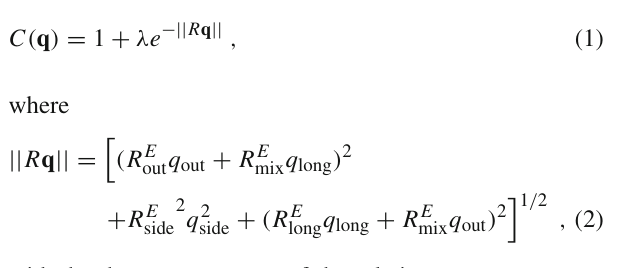
Fig. 1 Points represent the interferometry correlations for pions in central (0–1%) p+Pb collisions, calculated in the viscous hydrody- namic model; C ( q out , q side = 0 , q long = 0 ) (panel (a)), C ( q out = 0 , q side , q long = 0 ) (panel (b)), and C ( q out = 0 , q side = 0 , q long ) (panel (c)).Thesolidlinesrepresentthefittedcorrelationfunctionintheregion 0 . 025 GeV < | q | < 0 . 3 GeV